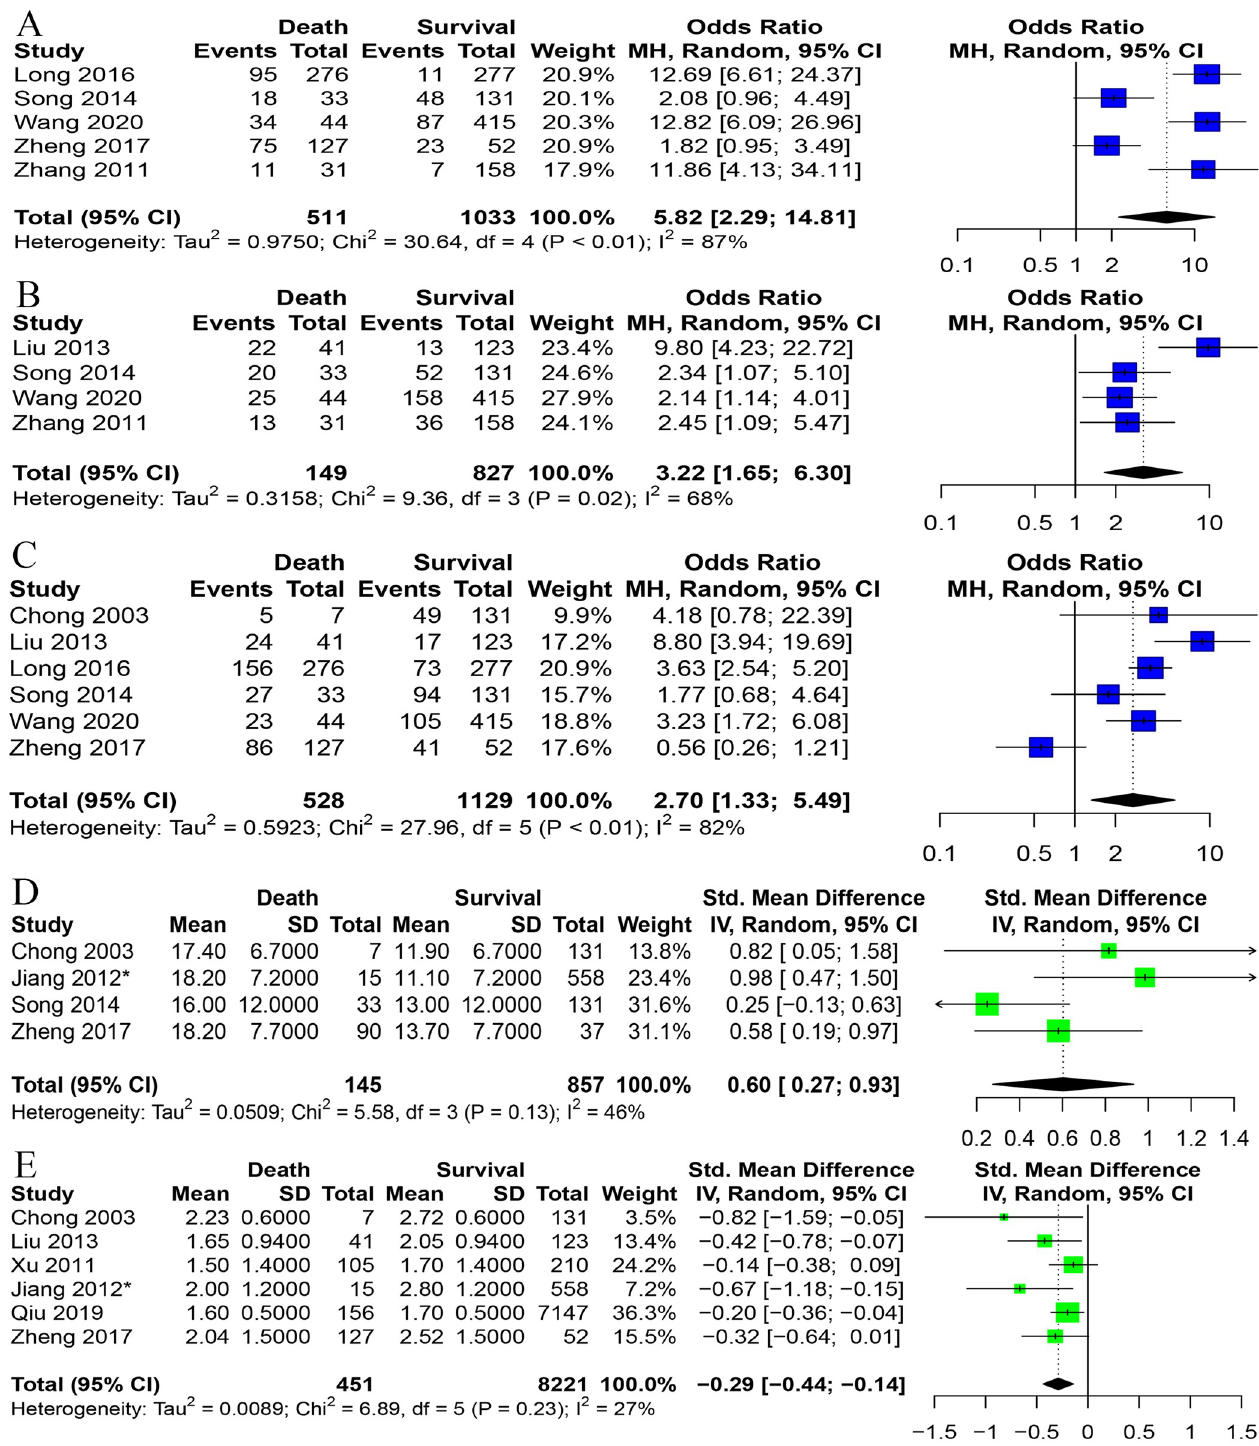
PLOS ONE | https://doi.org/10.1371/journal.pone.0267716 April 28,